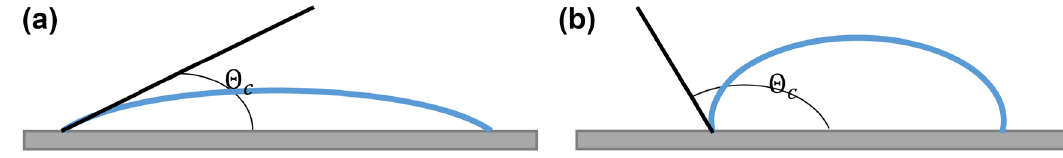
Fig. 5 Contact angles of a water-wet surface and b oil-wet surface (Alotaibi et al.